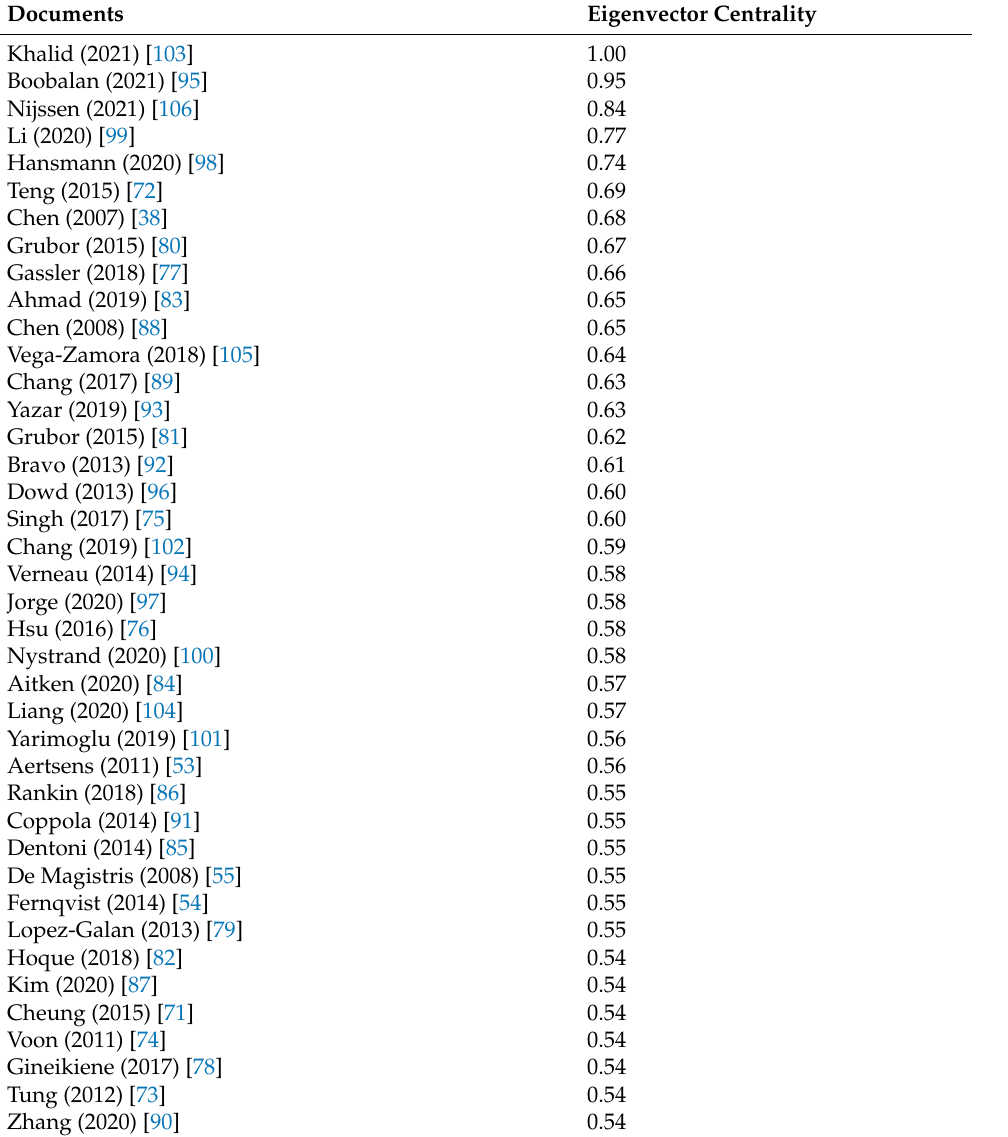
Table A1. The most relevant documents (top 40) considering centrality